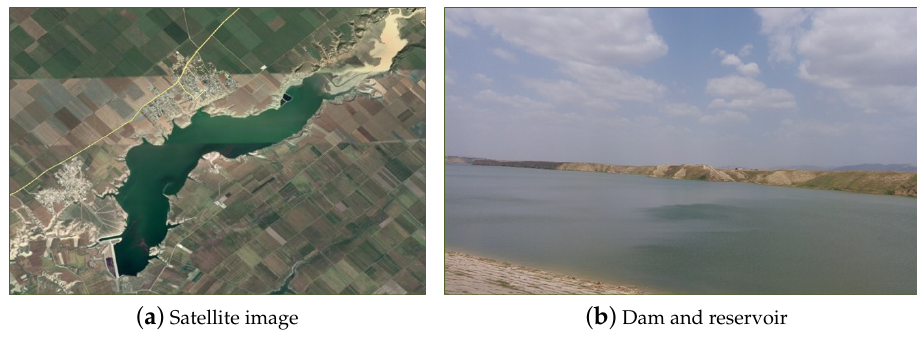
Figure 2. Boostan Dam.